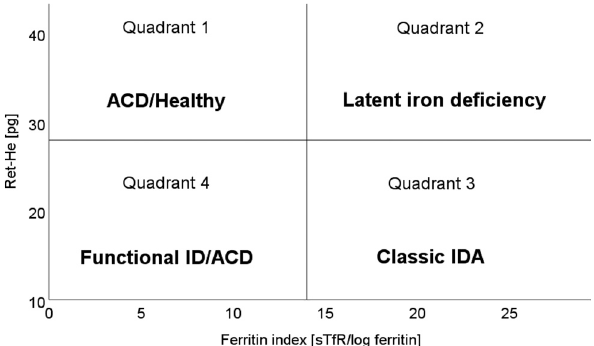
Figure 1: Diagnostic diagram (TP) with its four quadrants for the definition of different states of iron